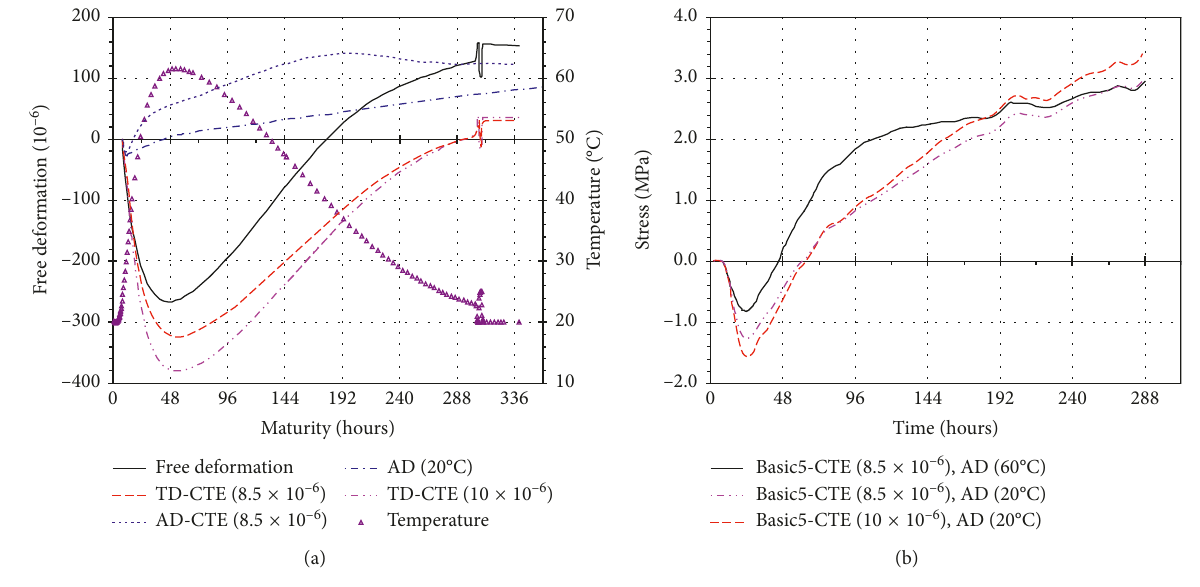
Figure 19: Different inputs of (a) total deformation and (b) stress development.